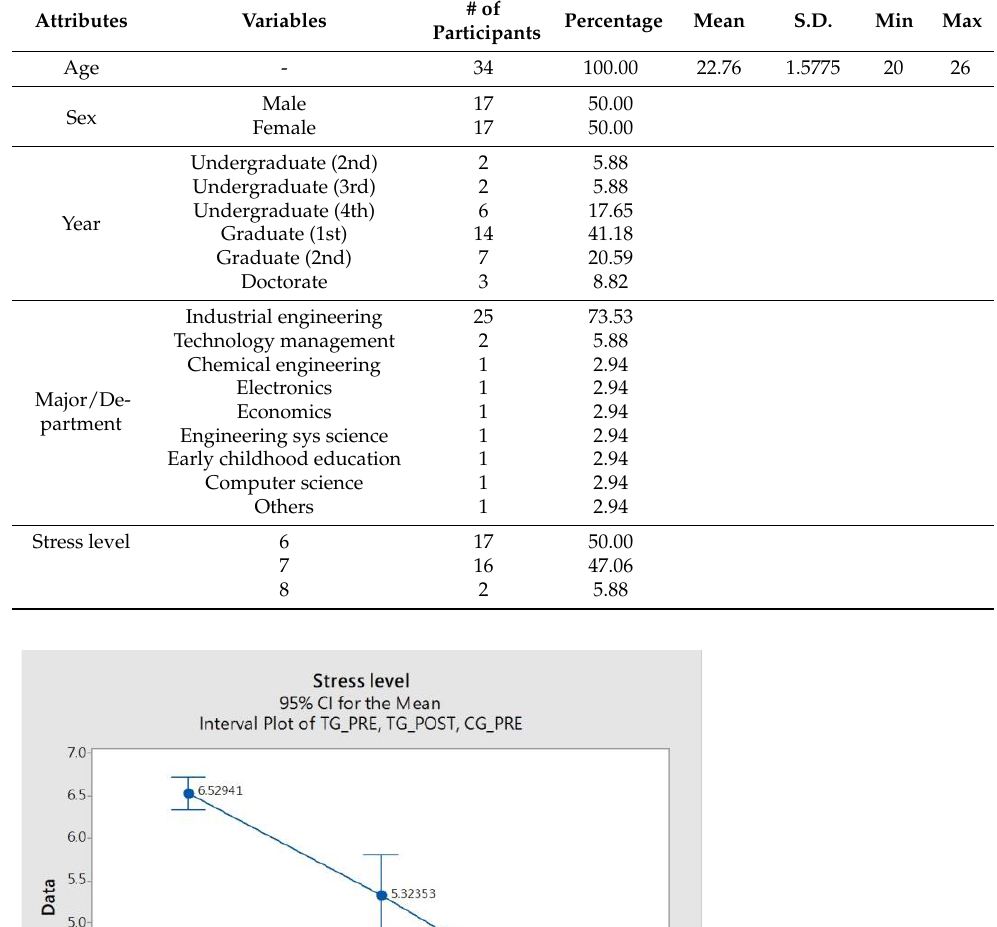
Table 2. Demographic information of participants.